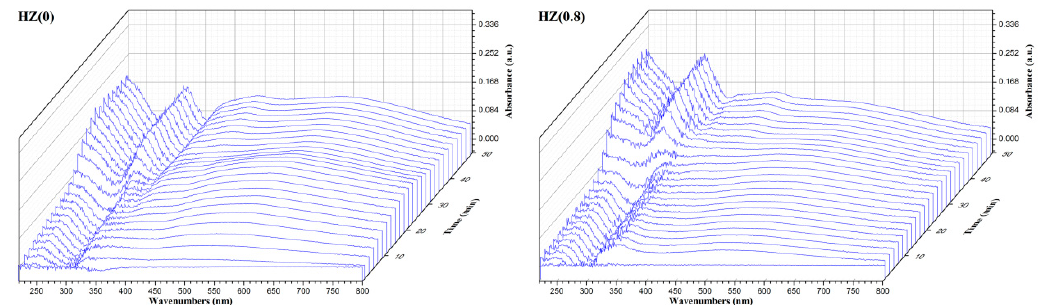
Figure 8. Operando DR UV-vis spectroscopy for conversion of propene over HZ(0) and HZ(0.8) catalysts at 250 °C.